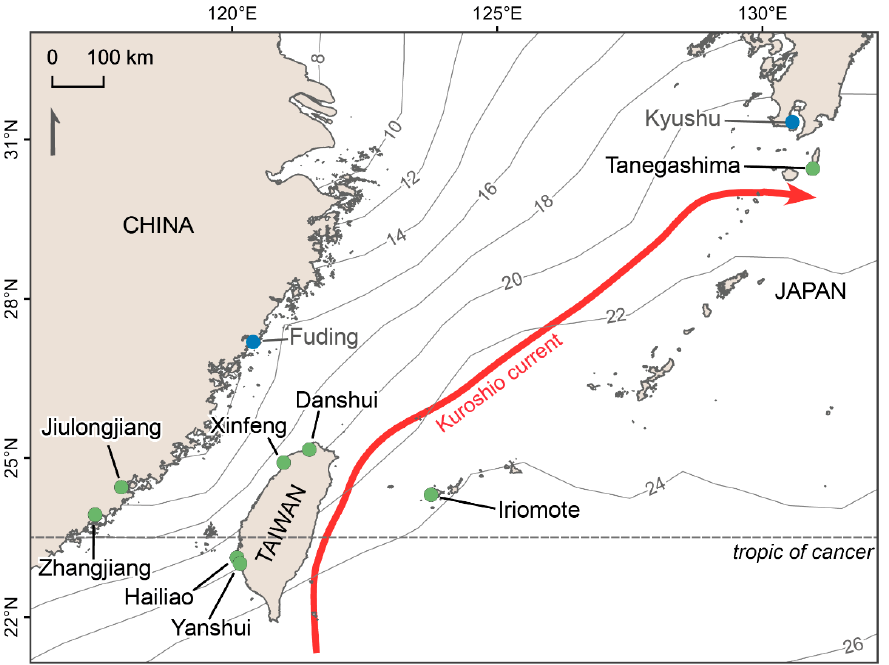
Figure 1. Location of the eight mangrove stands in North-West Pacific (green) along with the major oceanic current and sea-surface temperature isotherms (gray lines, °C) of January 2021 [48,49]. The northern limits of the natural mangroves distribution in the western Pacific are denoted with the two blue dots in Fuding and southern Kyushu.